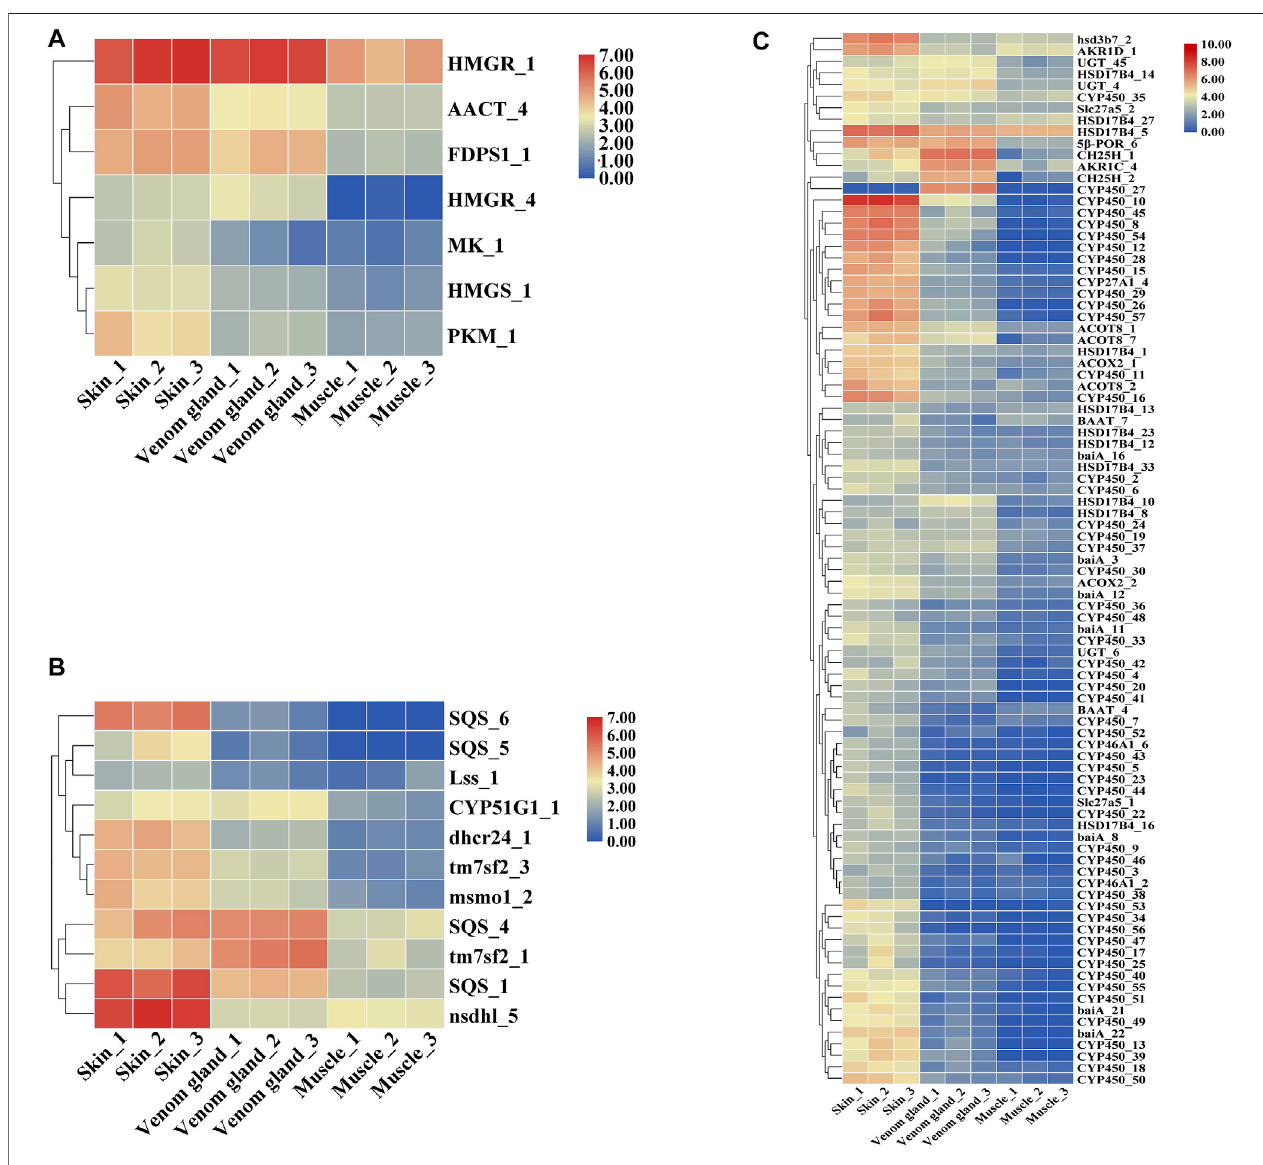
FIGURE 5 | The heat map of the expression pattern of genes involved in pregnenolone and bufadienolides biosynthetic pathway. (A) Upstream terpenoid backbone biosynthetic pathway, (B) Midstream cholesterol biosynthetic pathway, (C) Downstream pregnenolone and bufadienolides biosynthetic pathway.